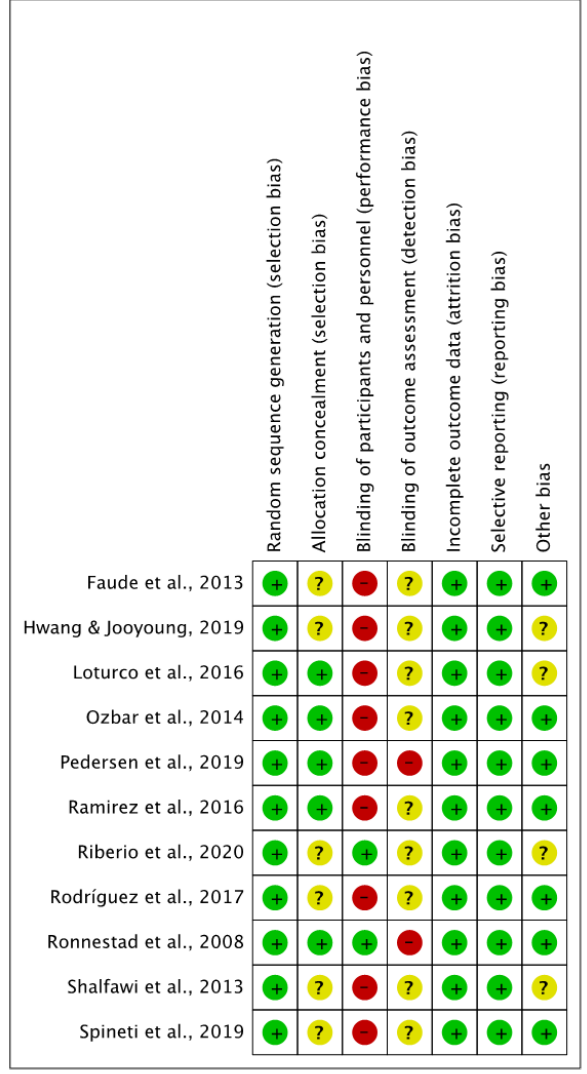
Figure 3. Risk of bias summary. (Green: low risk; Yellow: unclear risk; Red: high risk) [33 – 42] .